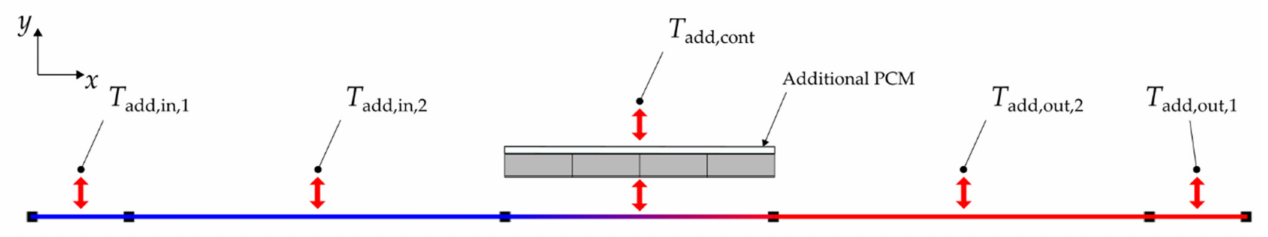
Figure 10. Extension of the model for validation purpose. The length of the 1D model is